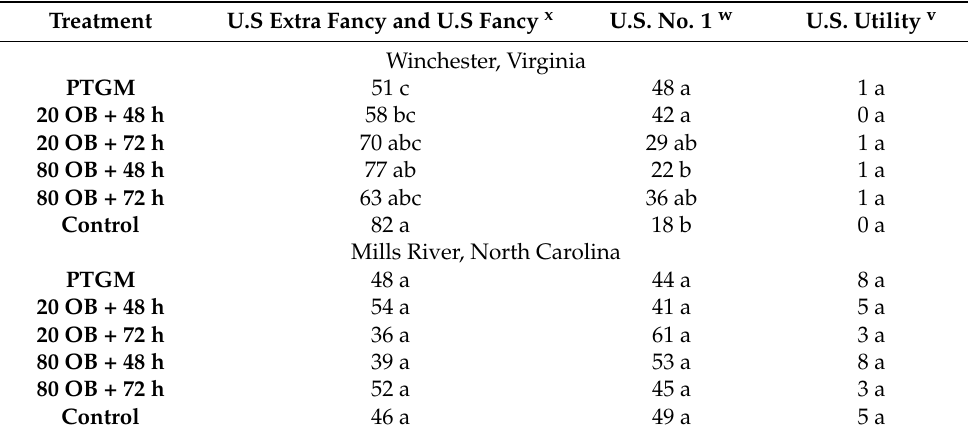
Table 6. Treatment effect on fruit packout according to fruit russet incidence/severity.